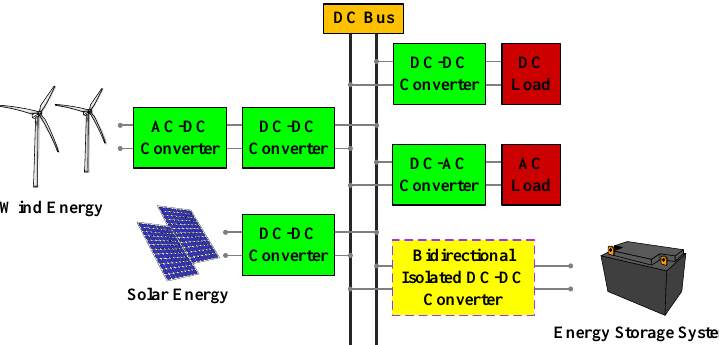
Figure 1. Configuration of the diversified energy system of the energy storage system.